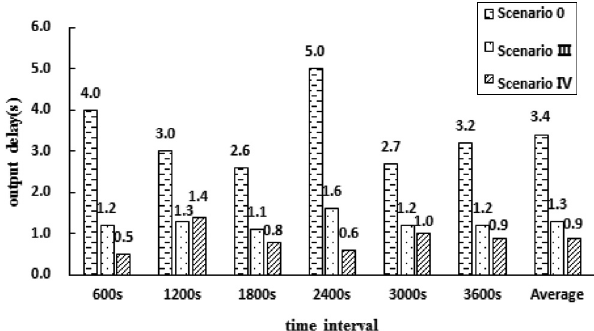
Figure 16 Average delay of current status and fi ne lane management